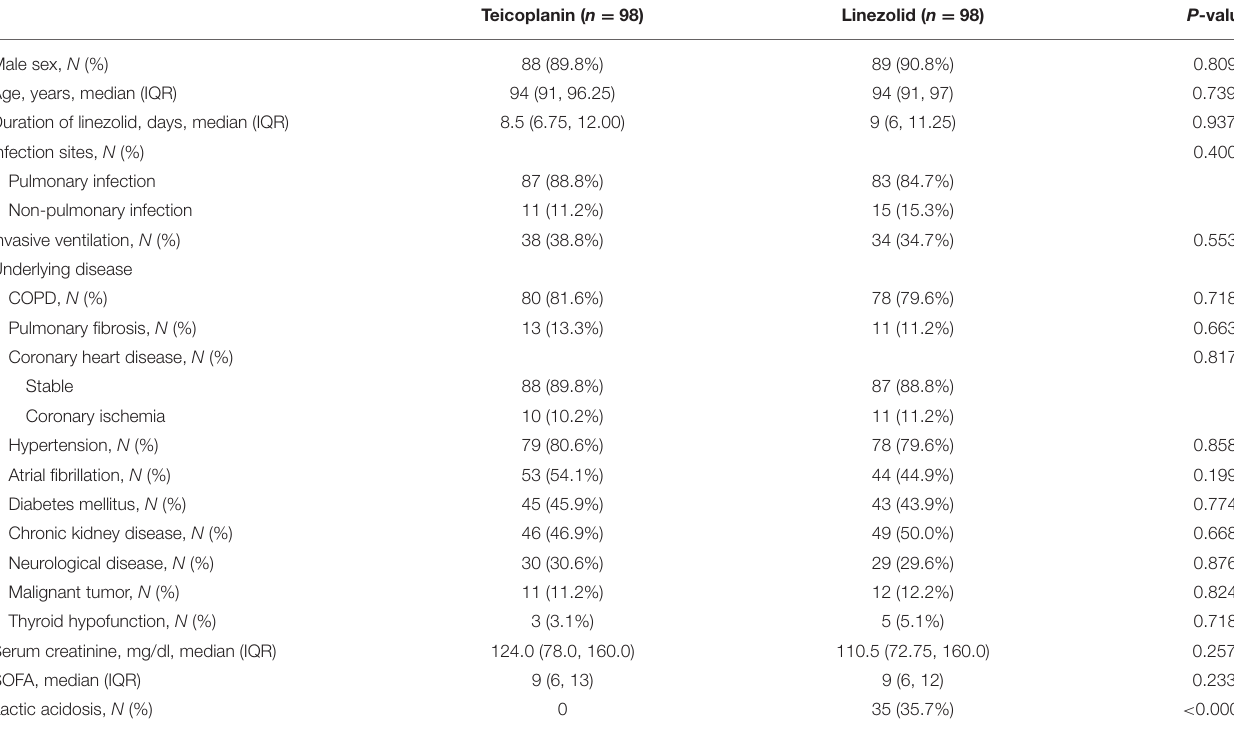
TABLE 1 | Patient demographic and clinical characteristics after propensity score matching (nearest neighbor matching).